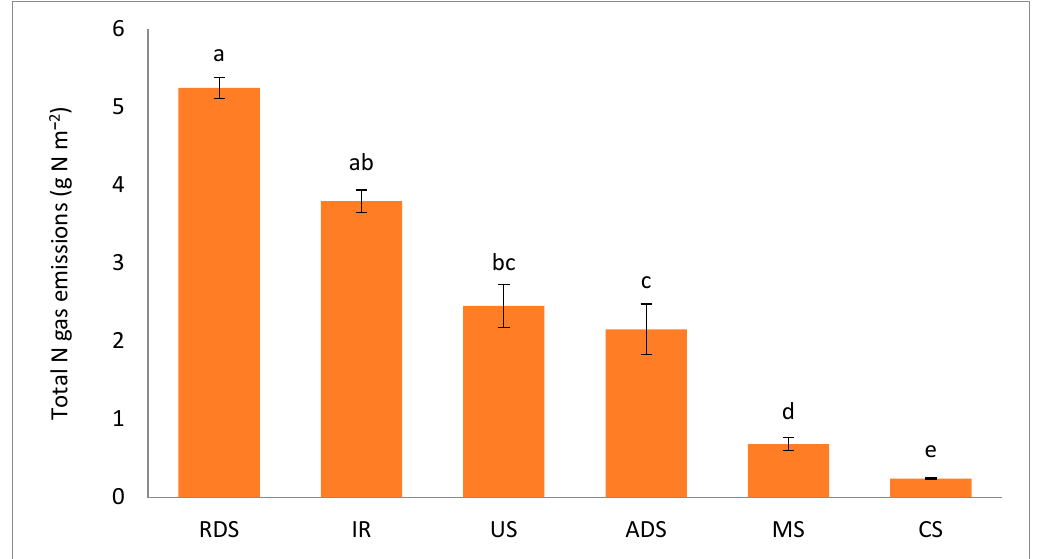
Figure 4. Total N lost via gas emissions (NH 3 –N + N 2 O–N) in g N m –2 . Different letters on the columns indicate significant differences among treatments ( p < 0.05) based on the Tukey test. Vertical bars represent the standard error of the mean (mean, n = 3).